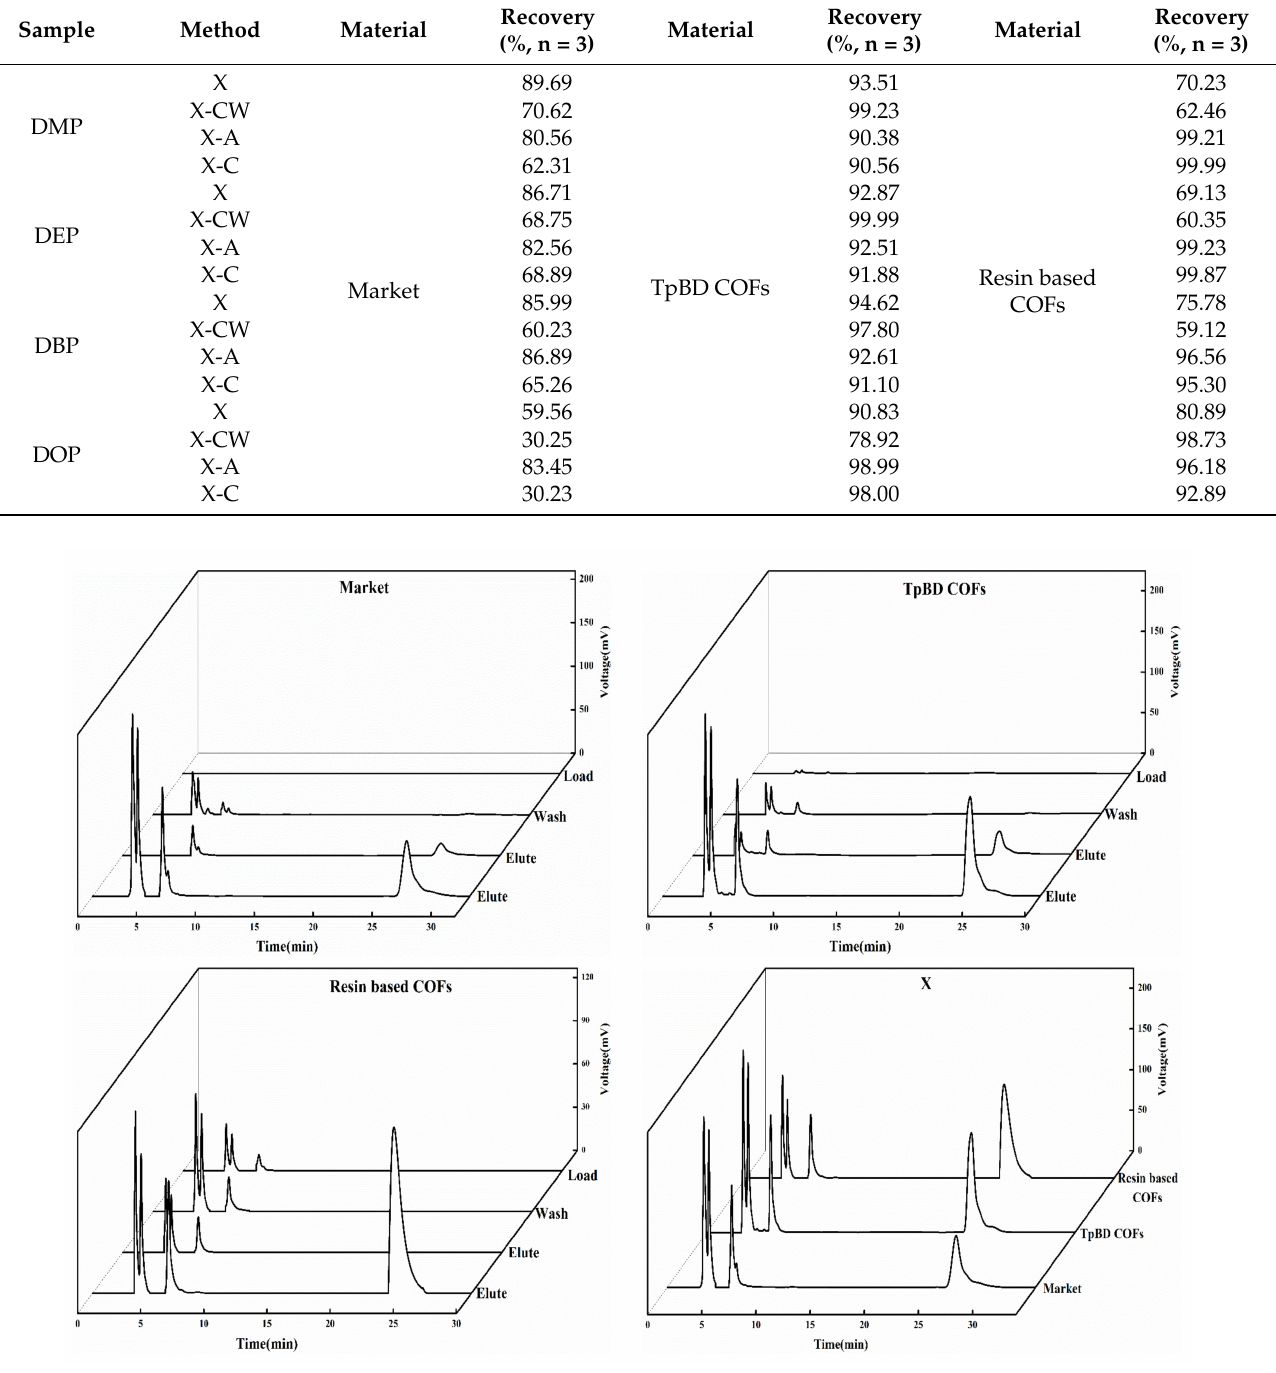
Figure 5. Outflow curves using the X